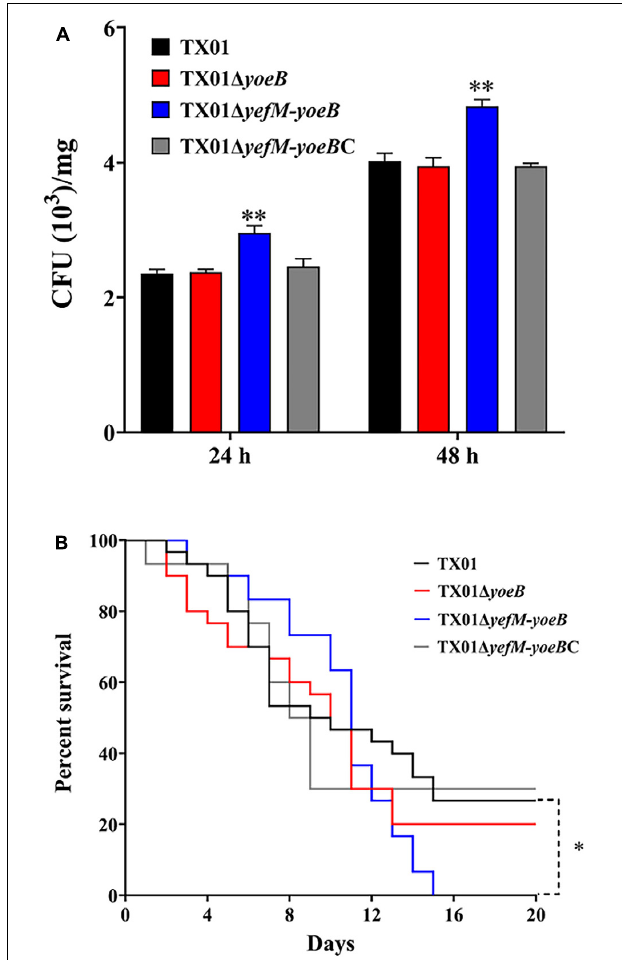
FIGURE 6 | Effects of yeoB and yefMyeoB mutation on bacterial dissemination of fish tissues and general virulence. (A) Bacterial dissemination in the fish tissues. Tilapia were infected with the same dose of TX01, TX01 (cid:49) yeoB , TX01 (cid:49) yefMyeoB , and TX01 (cid:49) yefMyeoB C, and bacterial recovery from the spleen was determined by plate counting at 48 and 72 h post-infection. (B) Host mortality induced by E. piscicida . Tilapia were infected with equivalent doses of TX01, TX01 (cid:49) yeoB , TX01 (cid:49) yefMyeoB , and TX01 (cid:49) yefMyeoB C, and accumulated mortality were monitored for a period of 25 days (only 20 days are shown since no more deaths occurred after 20 days). Significance between the survivals of wild type and mutant infected fish was determined with logrank test. Data are presented as the means ± SEMs ( N = 3). N, the number of times the experiment was performed. ∗ P < 0.05; ∗∗ P <